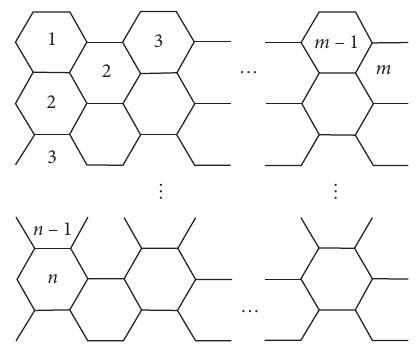
Figure 3: The 3D lattice of the armchair TUAC